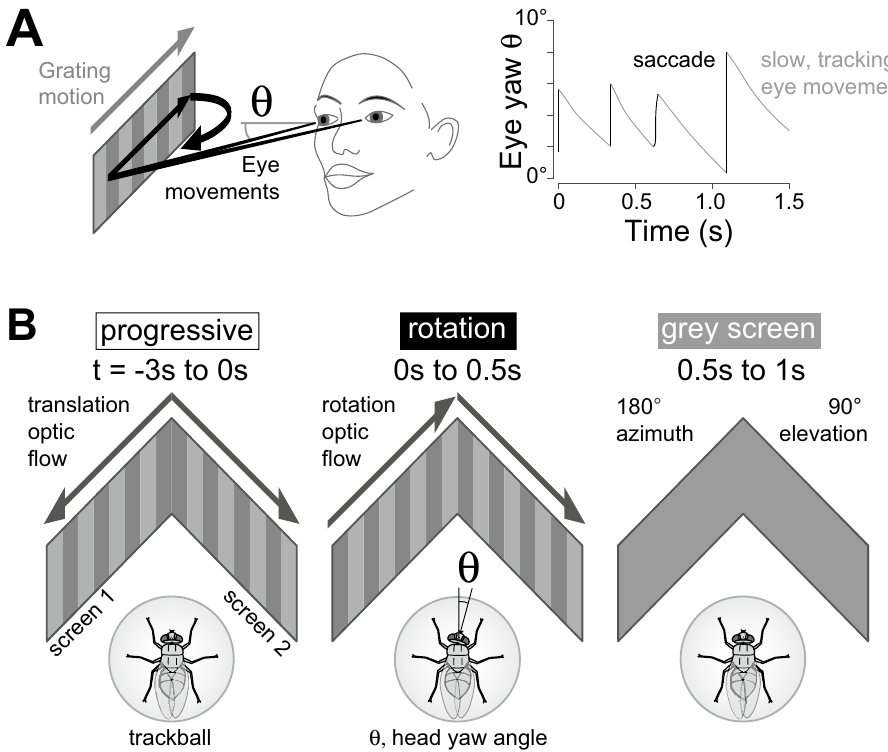
Figure 1. The optokinetic nystagmus and experimental setup and design. ( A ) Left: Schematic diagram of human optokinetic nystagmus eye movements in response to a grating moving horizontally left to right (grey arrow). The black arrows indicate the point of fixation moving rightwards as the eyes move syndirectionally with the grating, compensating for its motion. As the yaw angle of the eye’s principal axis (θ) increases towards the limit of its angular range, the eyes saccade leftward, against the motion of the grating. Right: Schematic traces of the yaw eye angle (θ), indicating saccadic increases of the yaw angle against the direction of grating motion, and slow decreases in the yaw angle of the compensatory eye movements that follow the direction of grating motion. The net result is the characteristic sawtooth pattern of yaw eye angle. ( B ) Experimental design. Left: In every trial, a fly first viewed a pre-stimulus screen for 3 s (t = − 3 s to 0 s) of gratings that moved progressively in a front-to-back direction (‘progressive’) with either one of the following temporal frequencies, 0 Hz, 0.25 Hz, 1 Hz, 4 Hz, 10 Hz, or a grey screen. Center: We measured the yaw angle (θ) of the fly’s head. During the stimulus period (t = 0 to 0.5 s) the fly viewed gratings moving in the same direction simulating the image motion that would occur during a yaw rotation (‘rotation’) with one of the following temporal frequencies, 0.25 Hz, 1 Hz, 4 Hz, 7 Hz, 10 Hz, 13 Hz, 18 Hz, 25 Hz. Right: After the stimulus period (t = 0.5 to 1.0 s), the fly viewed a grey screen. The visual field of the display screens spanned 180° azimuth and 90°